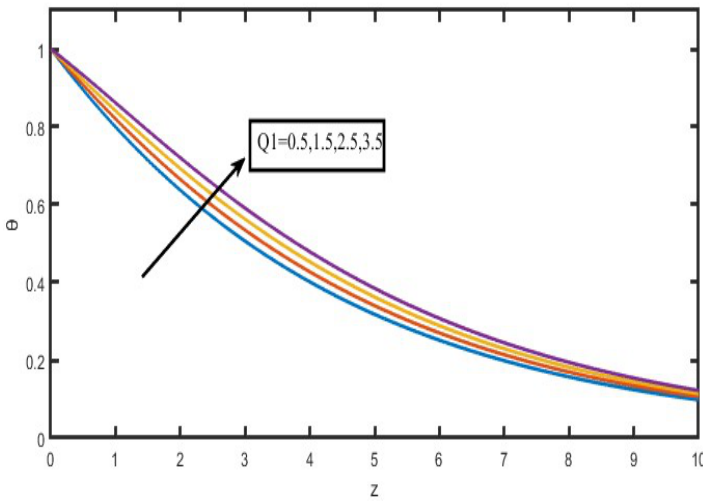
Figure 11. Temperature profiles for Radiation absorption (Q 1 ).